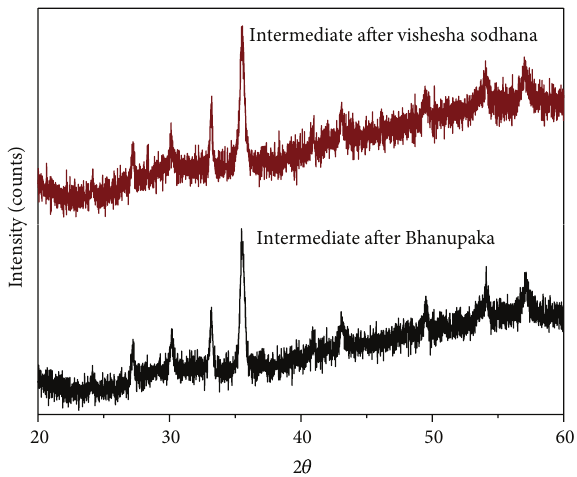
Figure5:PowderX-raydiffractogramofintermediateaftervishesha sodhana and the intermediate after Bhanupaka .